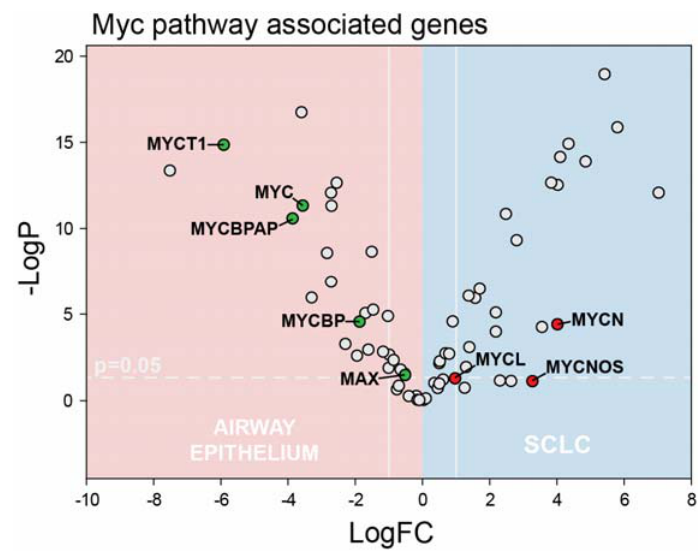
Figure 4. Volcano plot depicting changes in Myc ‐ family expression in SCLC. Only MYCN was significantly upregulated and MYCNOS was highly expressed. MYCN is highly expressed in neuroendocrine sub ‐ type of SCLC consistent with our samples collectively being representative of this sub ‐ type.